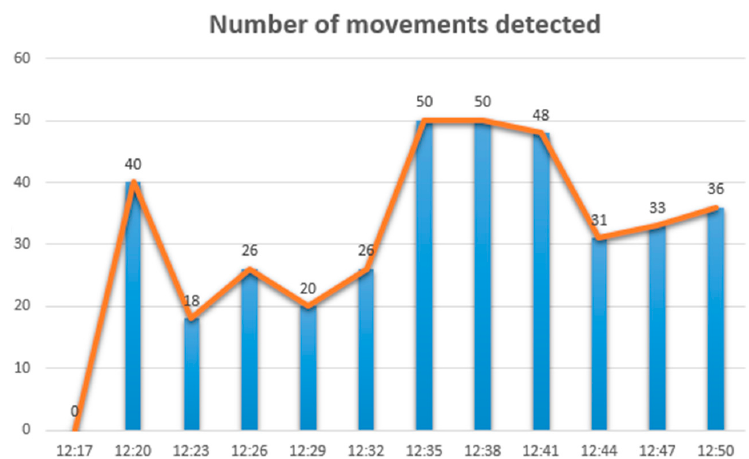
Figure 10. Increase of number of movements during a short interval in the restaurant.